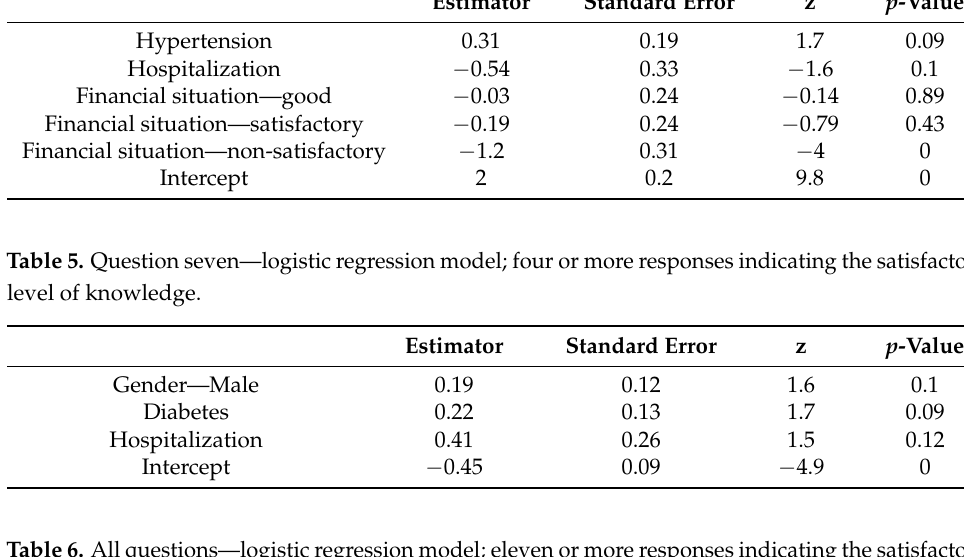
Table 6. All questions—logistic regression model; eleven or more responses indicating the satisfactory level of